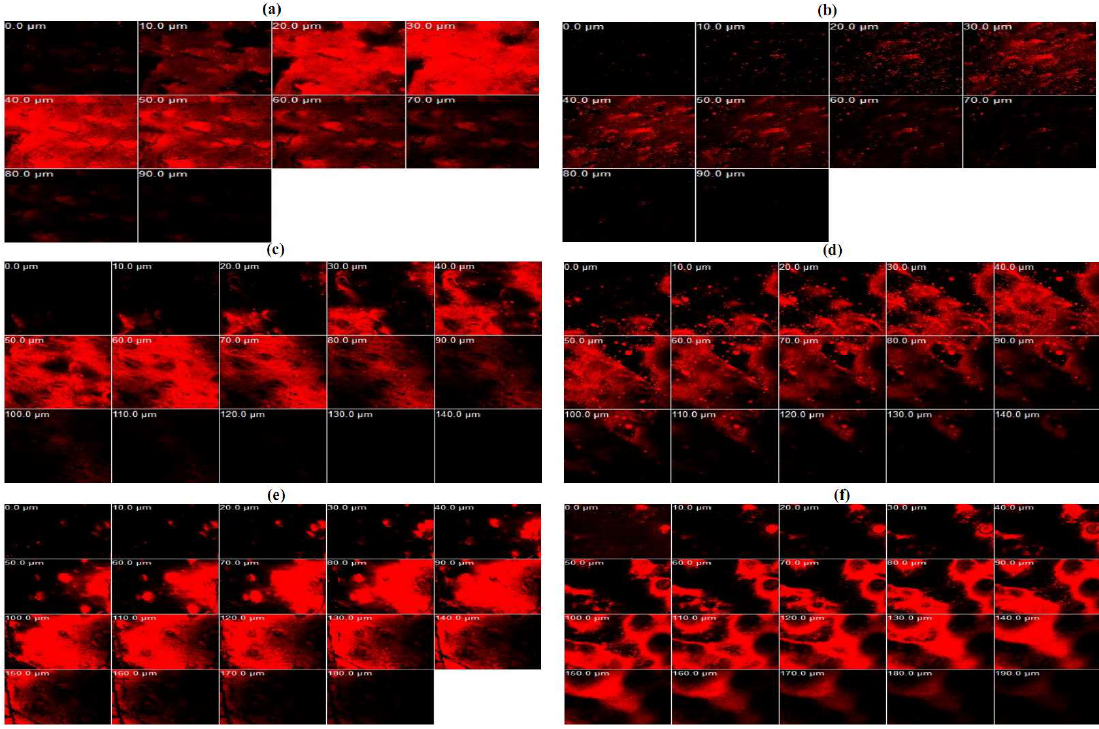
Figure 7. The confocal laser scanning microscopy images of the penetration of porcine buccal mucosa treated with Nile red-loaded NLCs ( a , c , e ) and Nile red in soybean oil ( b , d , f ) for 2 h (first row), 4 h (second row) and 8 h (third row).